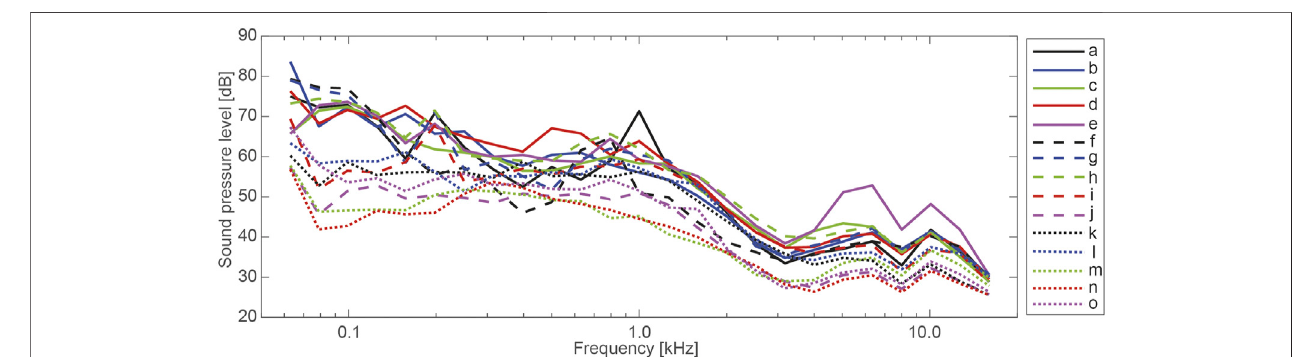
Frontiers in Built Environment |